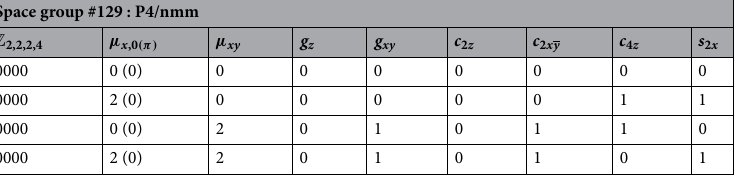
Z 4 symmetry indicators ×